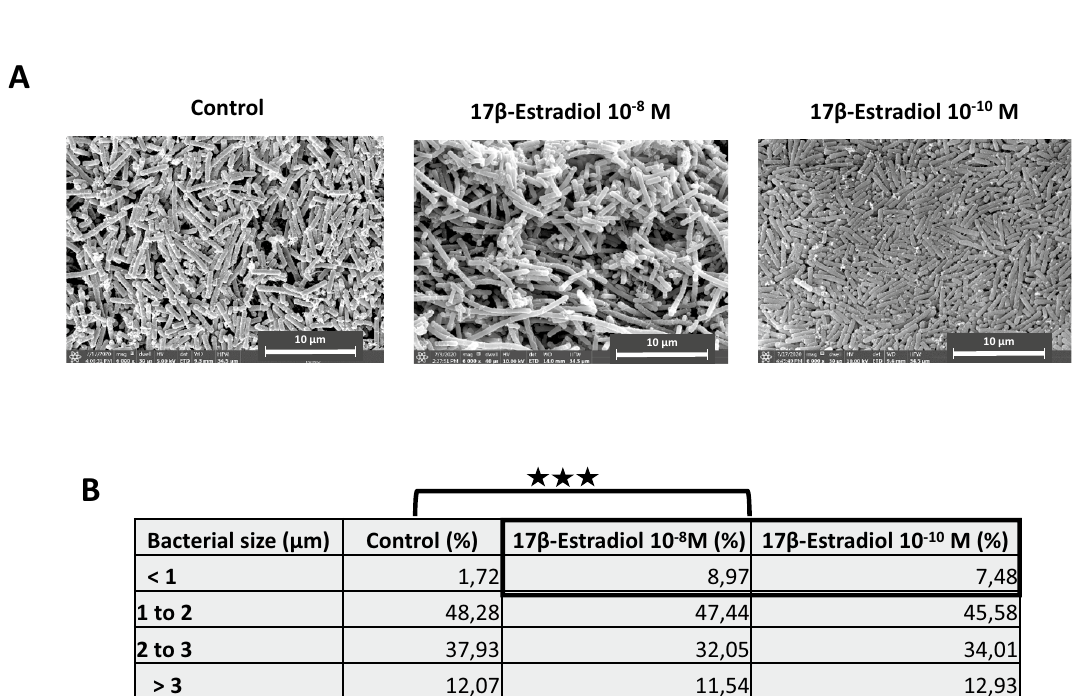
Figure 6. Effect of 17β-estradiol on the morphology of Lactobacillus crispatus V4. ( A ) Scanning electron microscope observations of L. crispatus V4 grown with or without 17β-estradiol (10 –8 or 10 –10 M). Scale bar = 10 µm. ( B ) Table showing the relative percentage of bacteria classified by size after culture with or without 17β-estradiol (10 –8 or 10 –10 M) ( p < ★★★